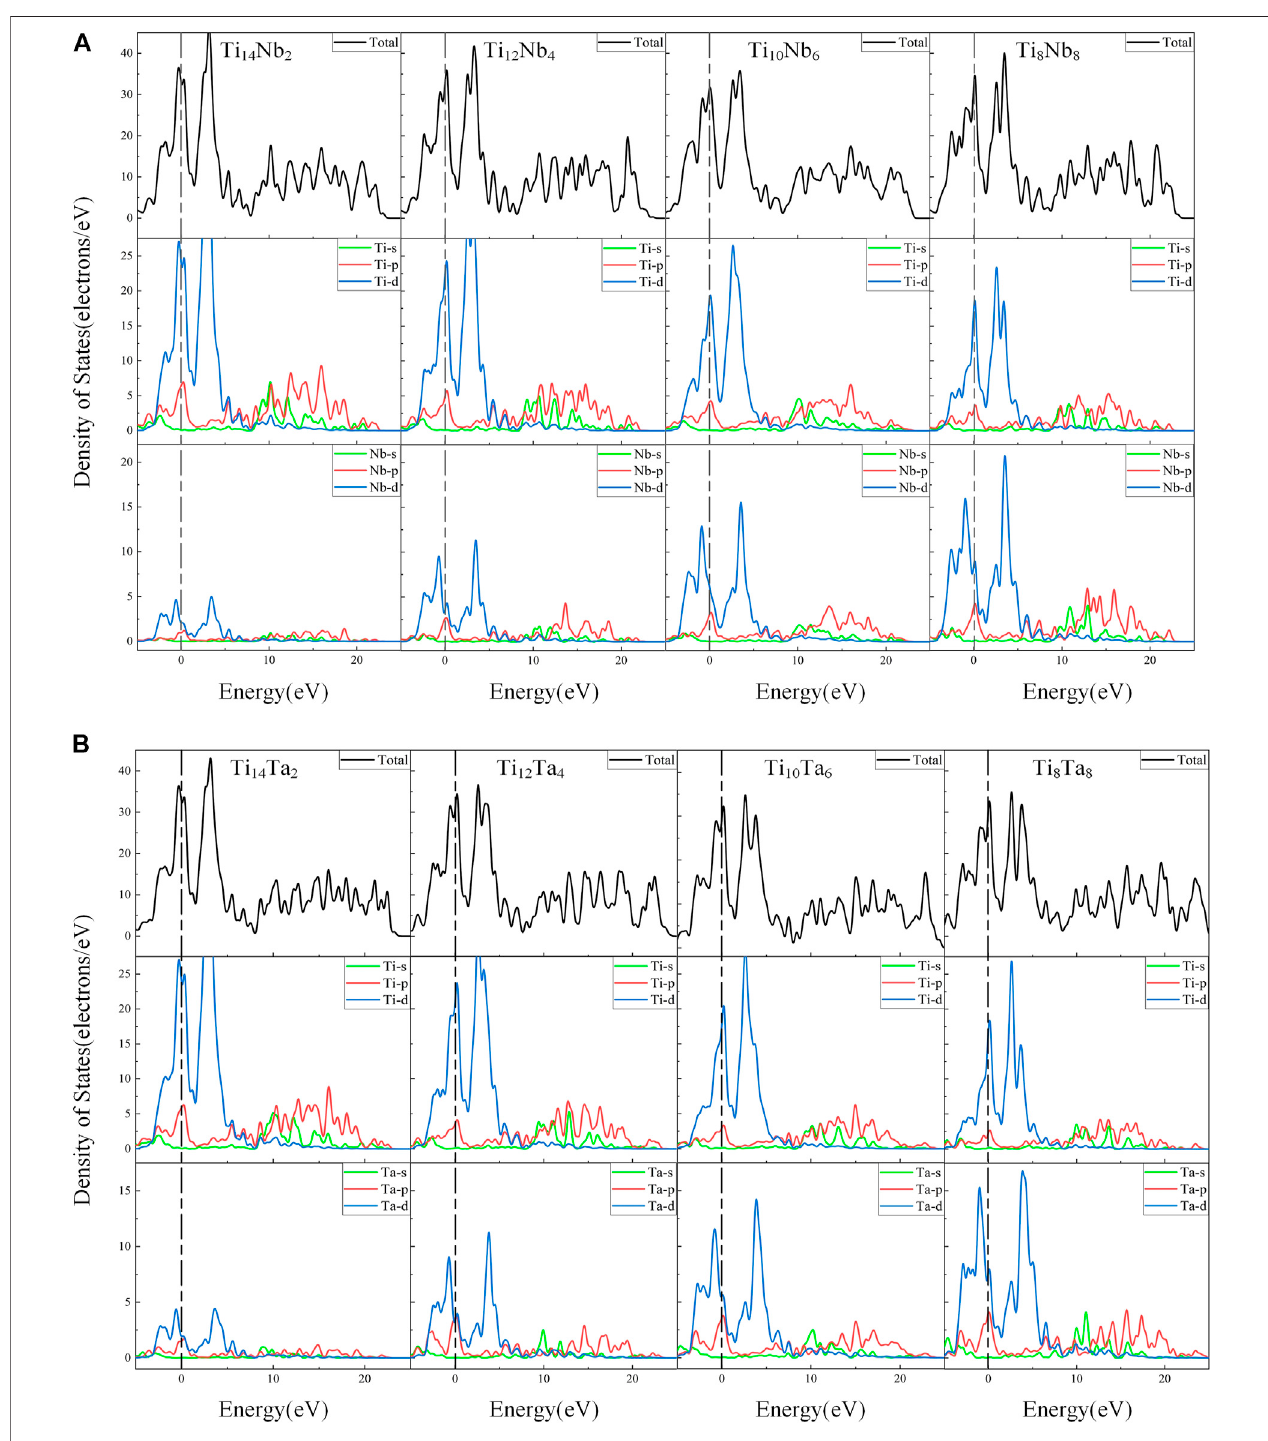
FIGURE 10 | TDOS and PDOS of (A) β -TiNb and (B) β -TiTa alloys.